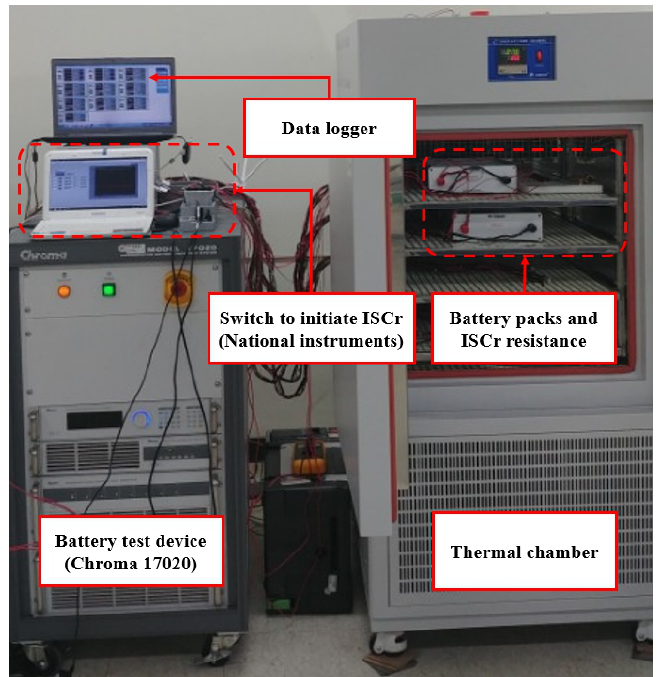
Figure 4. Experimental configuration for ISCr